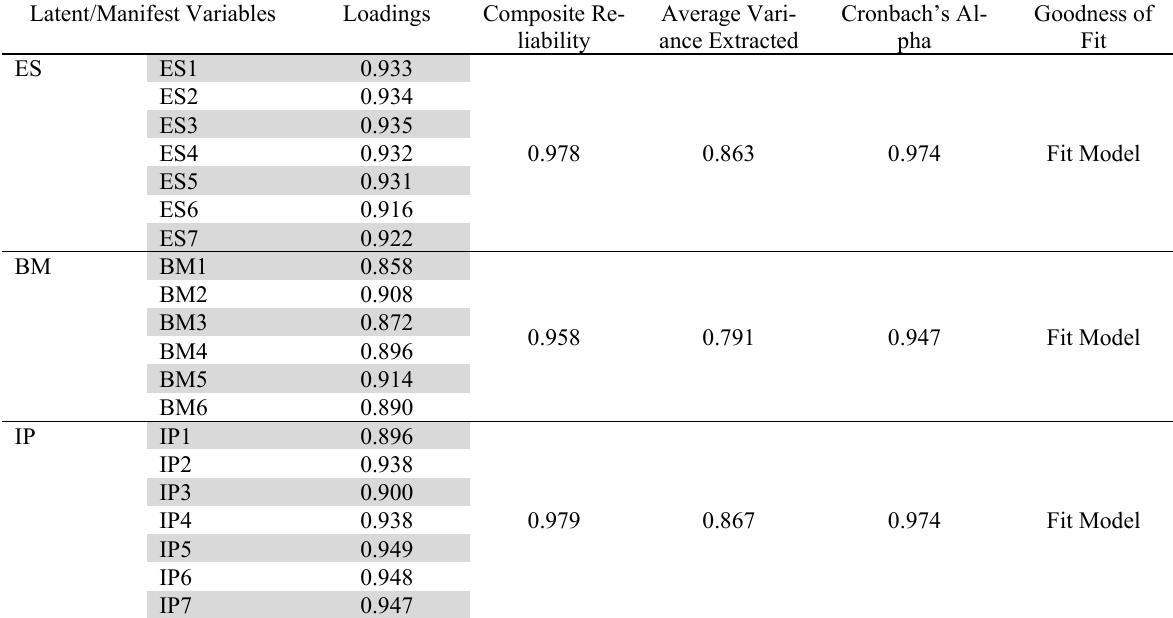
Measurement Model of Manifest